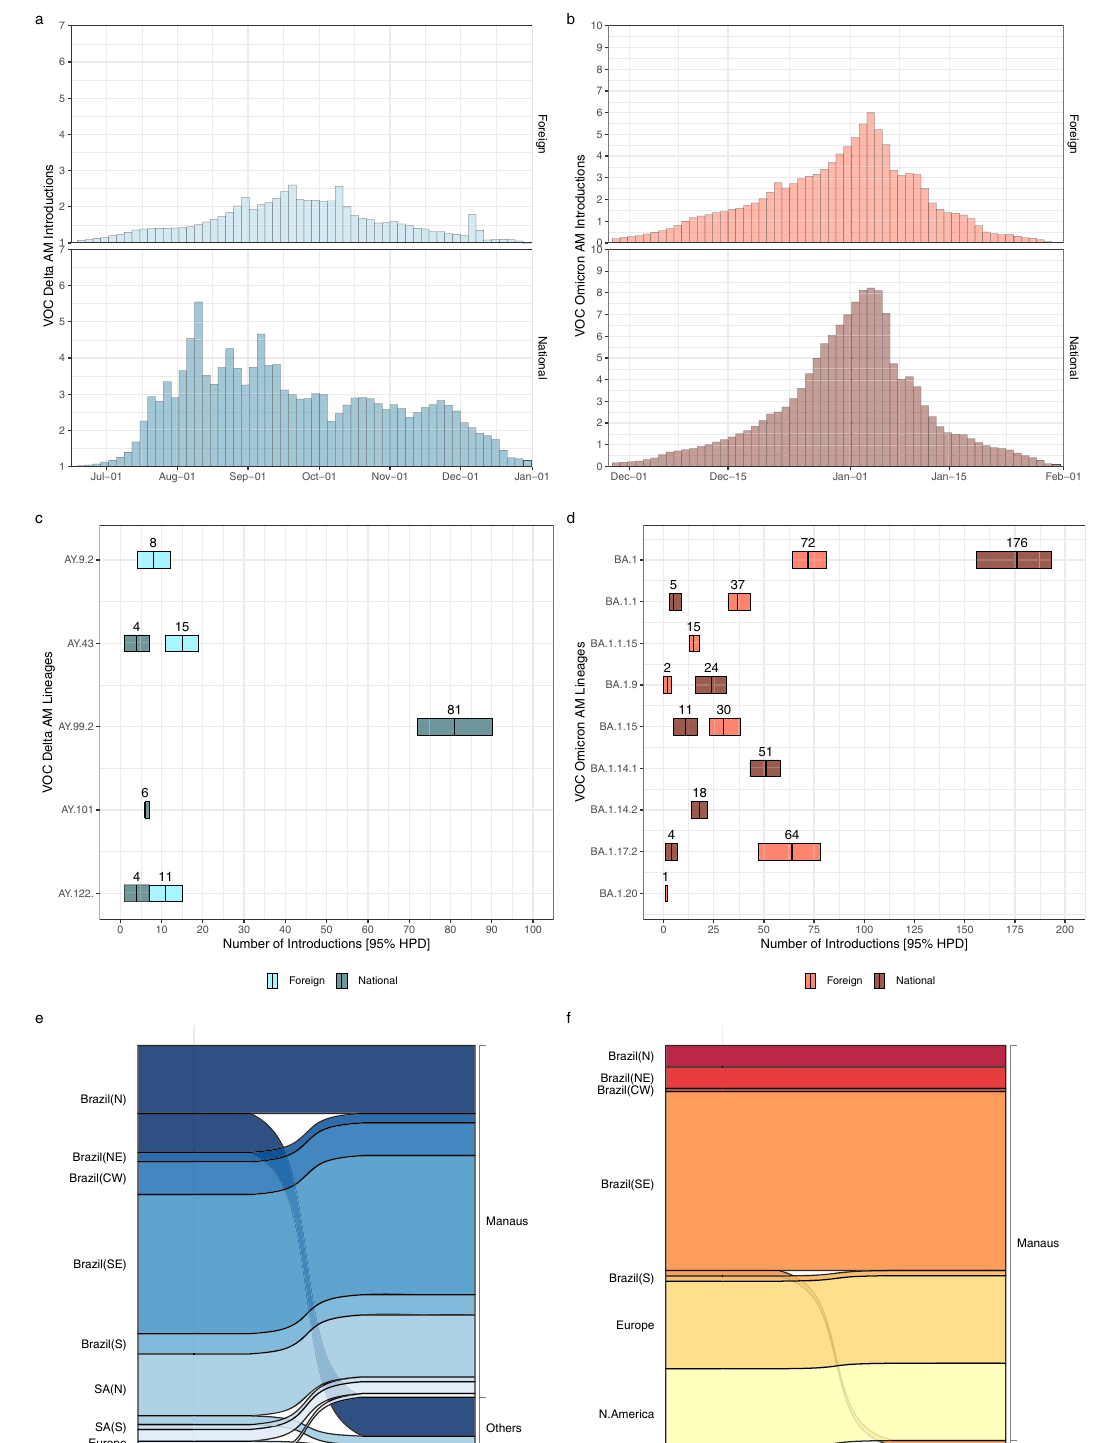
Fig. 3 | Estimated imports of the most prevalent Delta and Omicron lineages into the Amazonas state. a , b Estimated number of introductions of Delta and Omicron BA.1 into Amazonas state through time from other countries (foreign) or otherBrazilianstates (national), based onthe Markov jump historyin the Bayesian phylogeographic analysis of the most prevalent Delta and Omicron lineages com- bined. c , d Median(and95%HPDintervals)estimatednumberofDeltaandOmicron